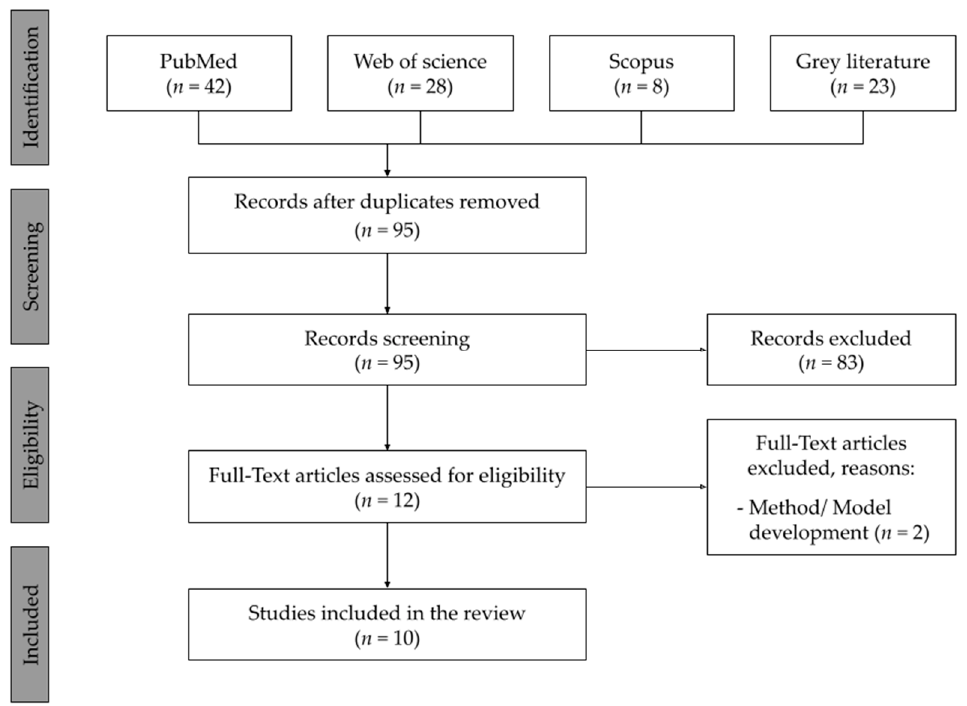
Figure 1. Summary of the inclusion and screening of articles following the PRISMA approach [30].